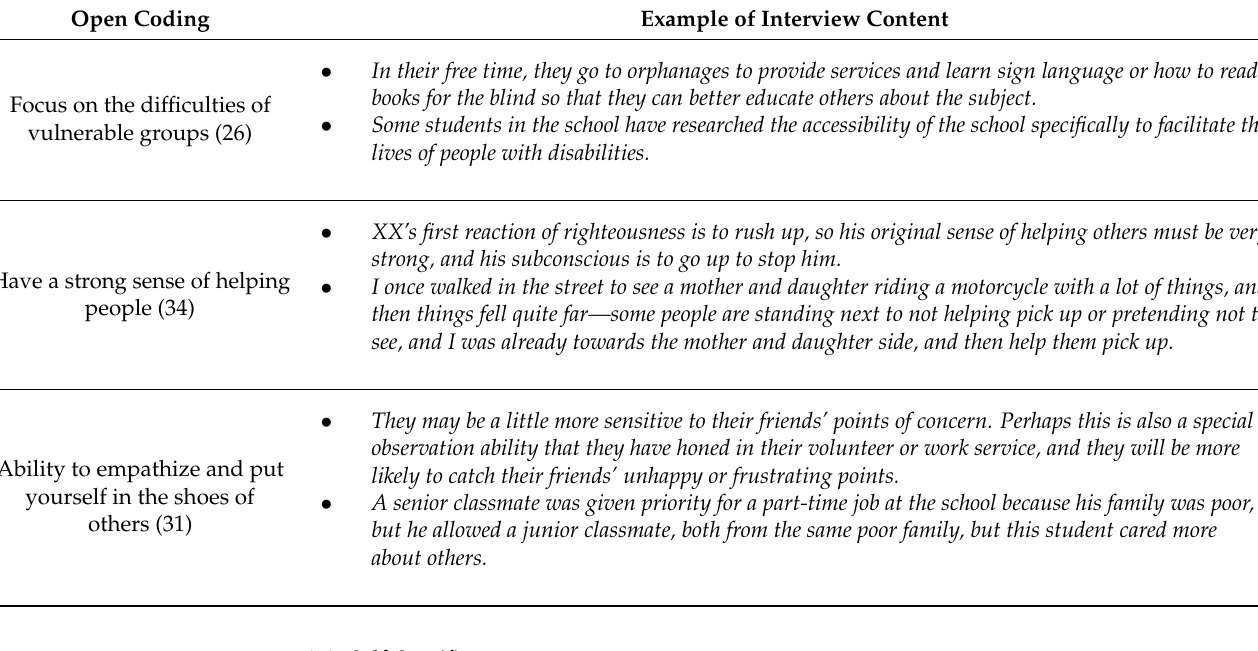
Table 4. Material information of the sub-node “compassion” by axial coding.